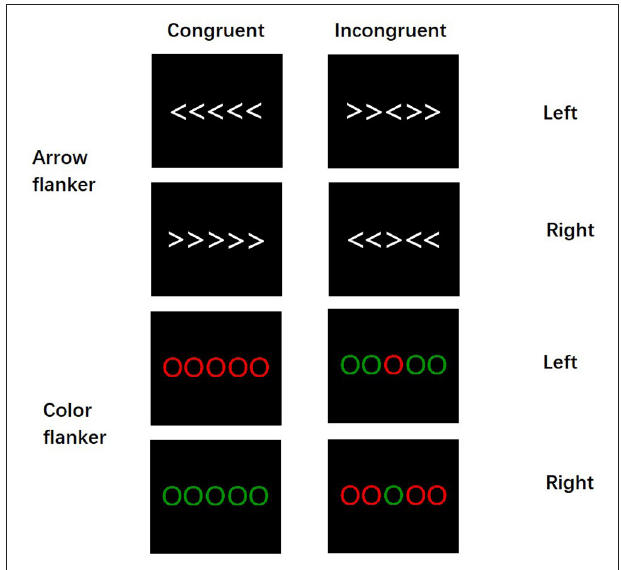
FIGURE 1 | The arrow flanker task and the color flanker